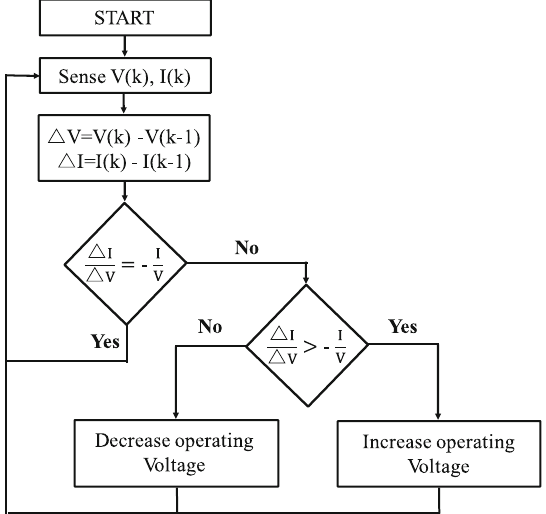
Fig. 5 The flowchart of the IC-MPPT